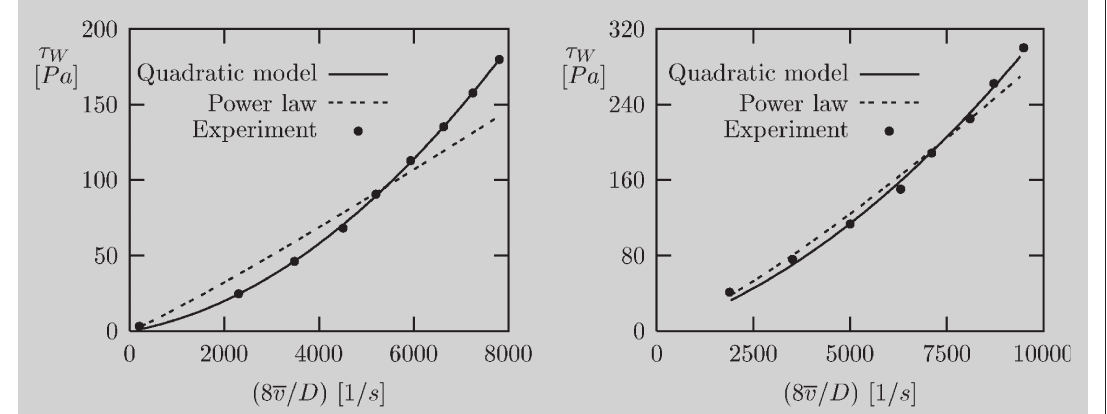
Figure 1: Comparison of experiment and rheological model (left: Mixture I, right: Mixture